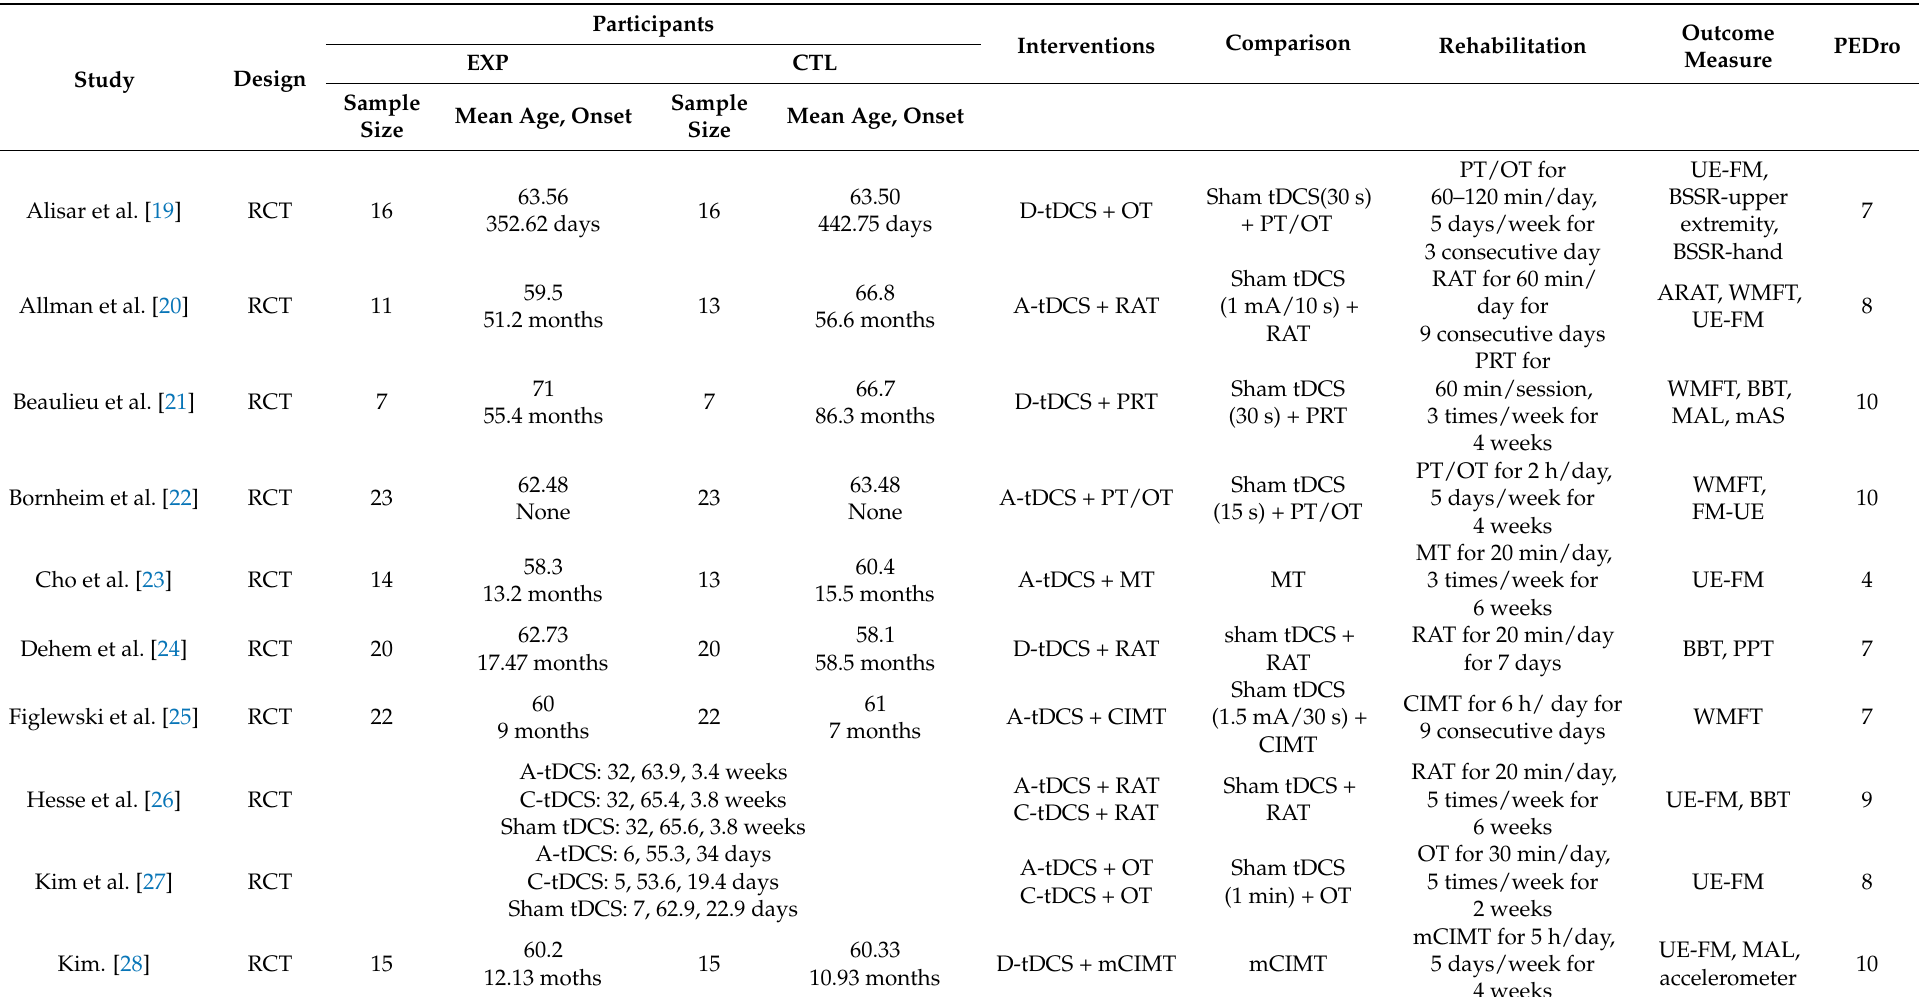
Table 1. Characteristics of studies examining the effects of tDCS combined with other rehabilitation therapies on upper extremity function (cont-).